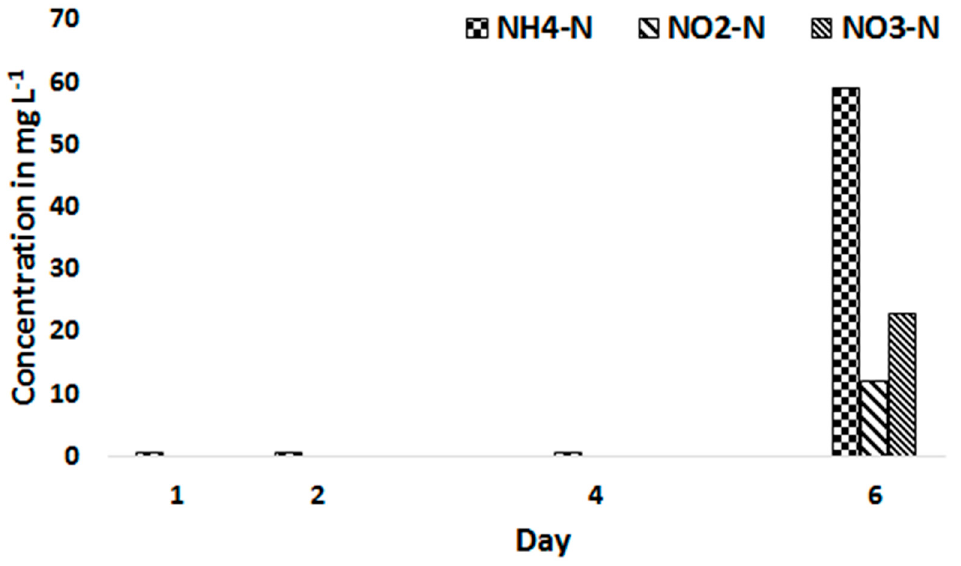
Figure 6. NH 4 -N, NO 2 -N, and NO 3 -N concentrations in the effluent culture during the 6th day feeding period.